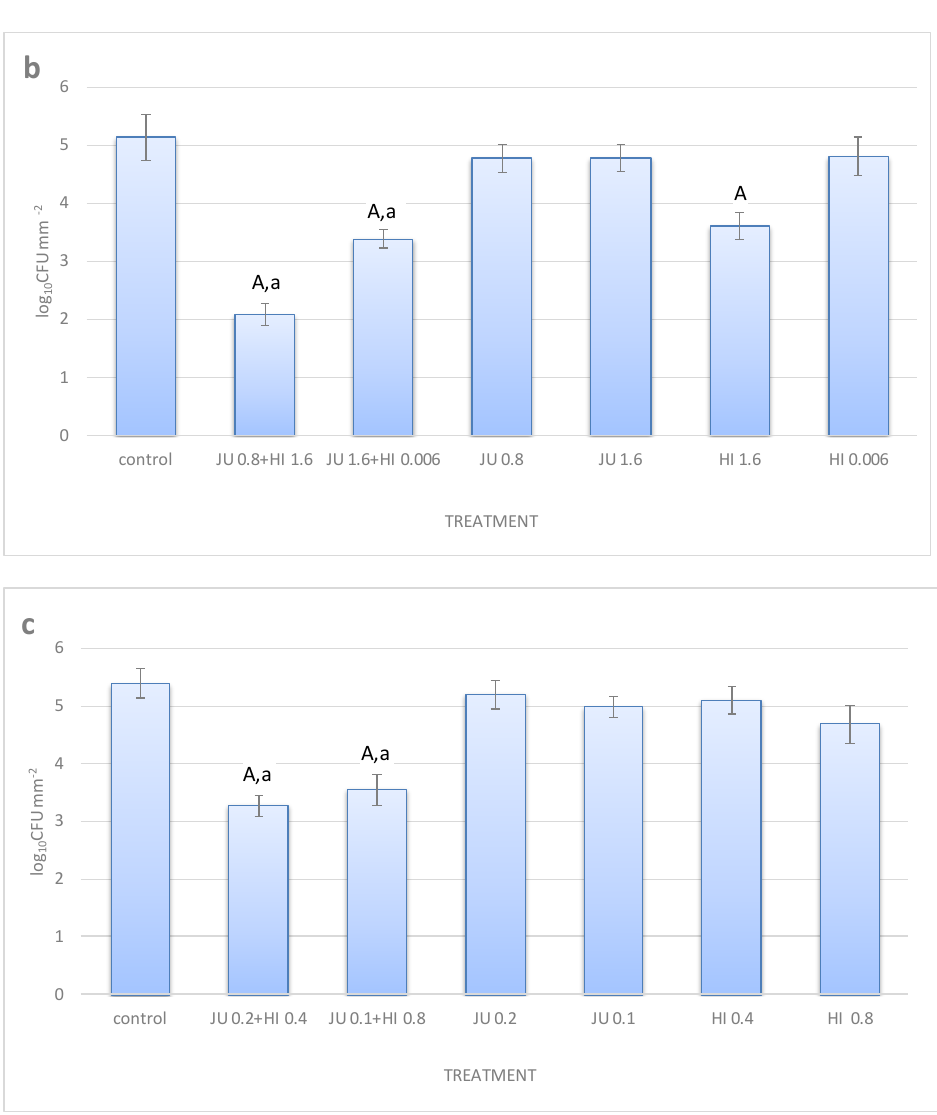
Figure 4. Effect of synergistic or additive concentrations of J. communis and H. italicum EOs in mg mL −1 on biofilm degradation of M. avium ( a ), M. intracellulare ( b ), and M. gordonae ( c ) formed on stainless steel discs. Untreated mycobacterial cells served as controls. MIC—minimum inhibitory concentration; CFU—colony forming unit; JU— Juniperus communis ; HI— Helichrysum italicum . The experiment was repeated three times in duplicate and the mean ± SD is shown. Mean values marked with an uppercase letter A were significantly different compared to the control group. Mean values marked with a lowercase letter a represent significant differences in synergistic and individual groups of EOs ( p < 0.05).